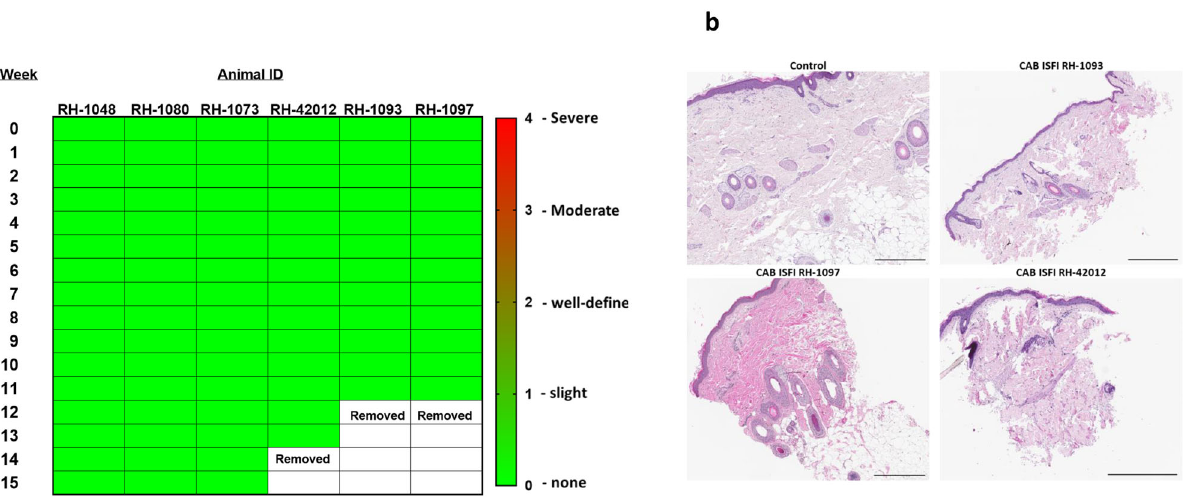
Fig. 6 | Safety and tolerability of CAB ISFI implants in rhesus macaques. a Heatmapoflocal skin reactions atthe implant site in the six ISFI-treated animals. Local skin reactions were scored using a Draize scale (0-none to 4-severe). b Histopathology of skin. One skin biopsy per animal was collected at the